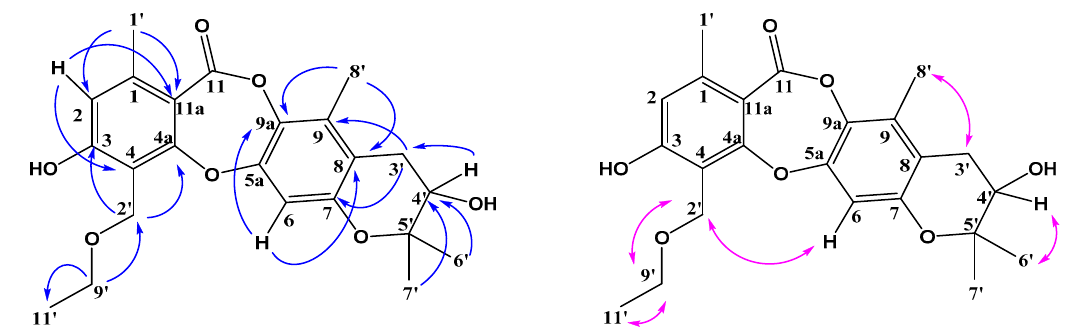
Figure 4. Key HMBC (H-C) correlations and NOESY (H-H) correlations of mollicellin Q ( 3 ).